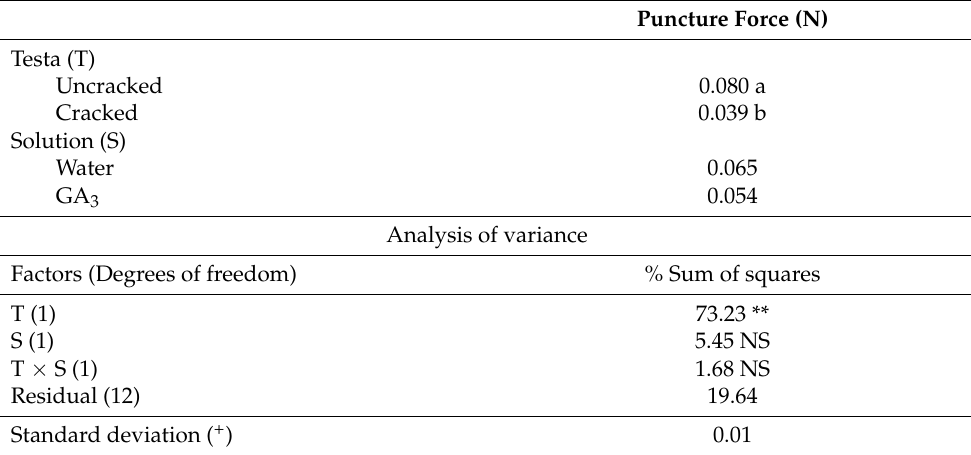
Table 4. Effect of the testa cracking and the solution used to wet the germination substrate in the germination test on the puncture force required to pierce the micropylar endosperm at three days after testa cracking. Mean values of 4 replicates of 10 seeds